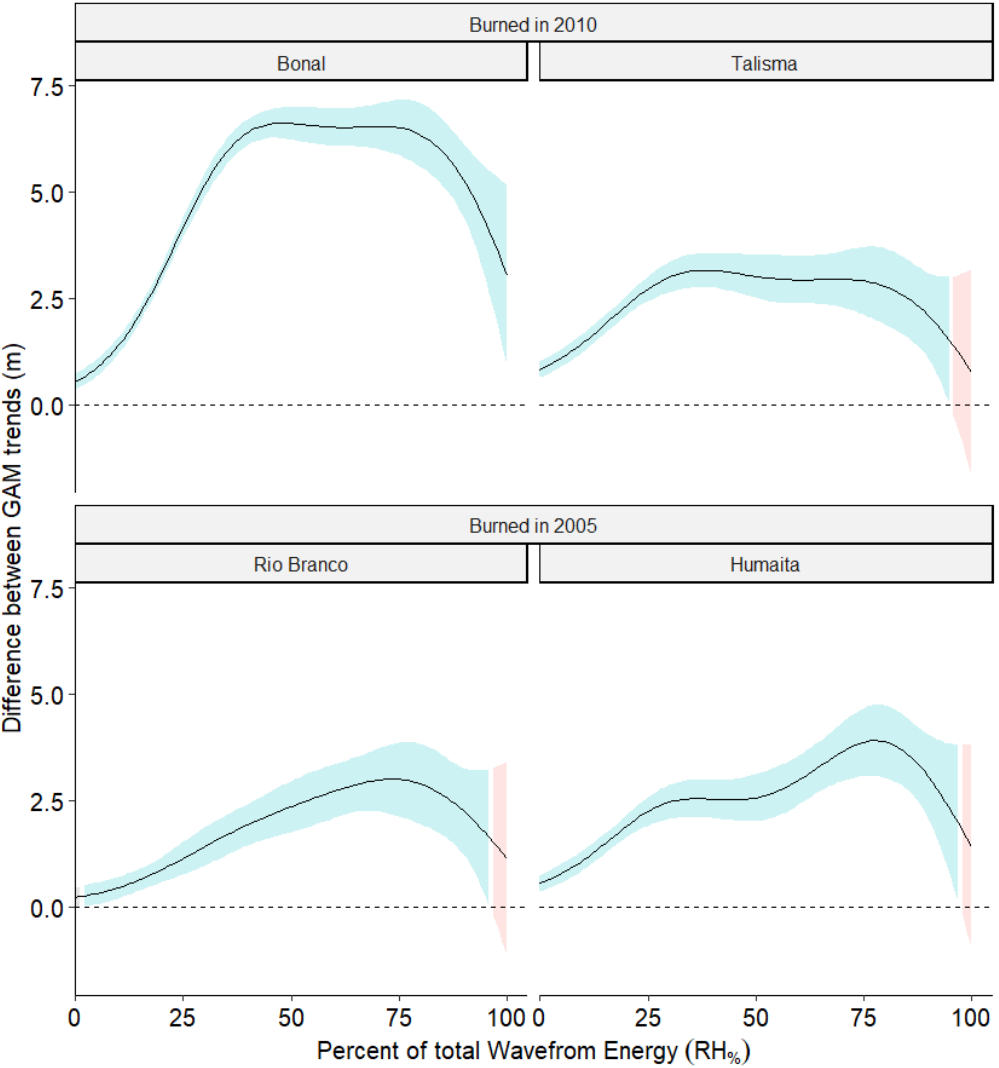
Figure 7. Differences between GAM fit lines with 95% confidence interval bands. Positive differences indicate that unburned forest has higher height returns than burned. Band color indicates significance as measured by whether the CI overlaps 0, blue indicates significant differences, and red indicates no significant difference.